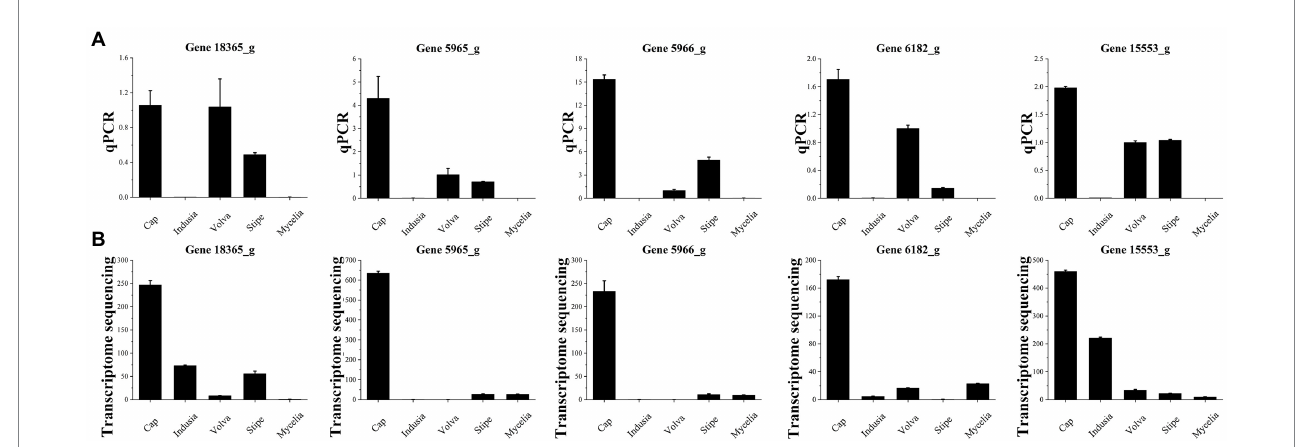
FIGURE 11 qPCR validation of five genes of five DI tissues identified from transcriptome sequencing. (A) Transcriptome sequencing results of the five genes in five DI tissues. The abscissa represents the tissues, and the ordinate represents FPKM expression levels. (B) qPCR analysis of the five genes in five DI tissues. The abscissa represents the tissues, and the ordinate represents the 2 - ∆∆ Ct